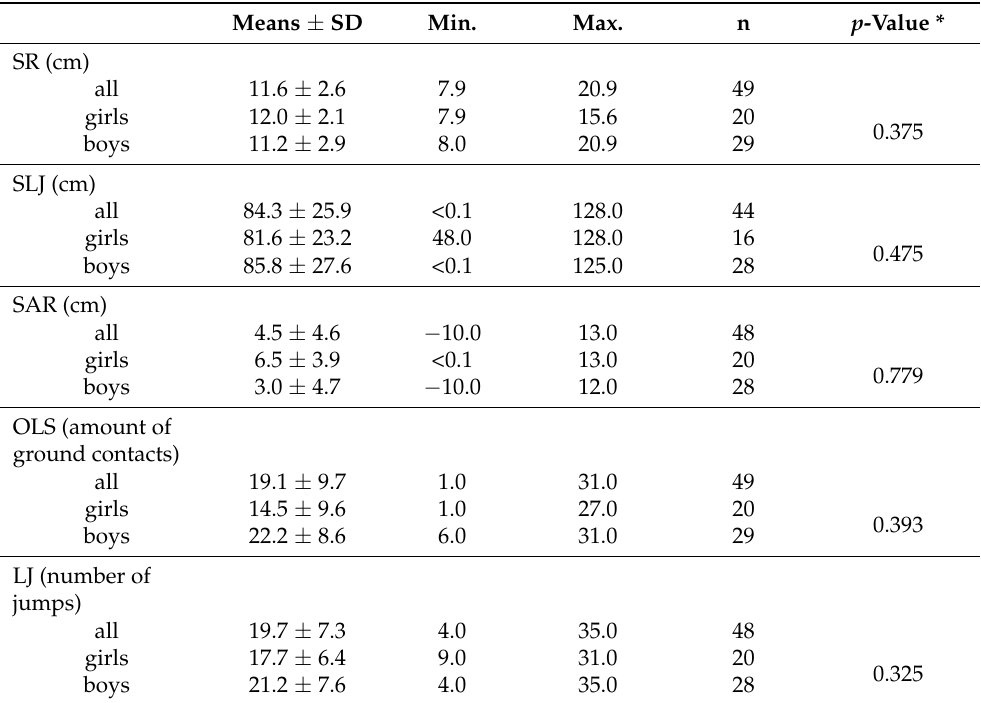
Table 2. Results of the motor skills assessment KiMo overall and separated by gender. Means ± SD Min. Max. n p -Value